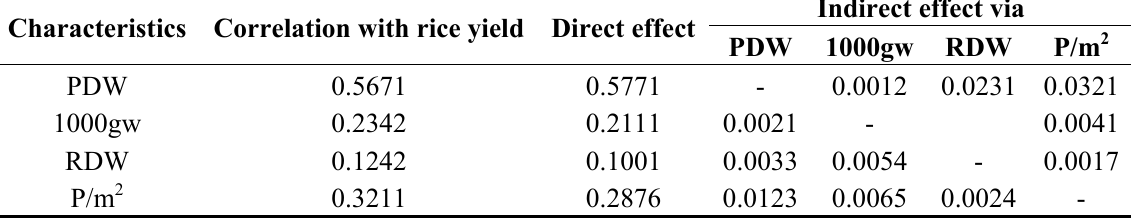
Table 3. Path Coefficient Analysis showing direct and indirect effects of growth characteristics with rice